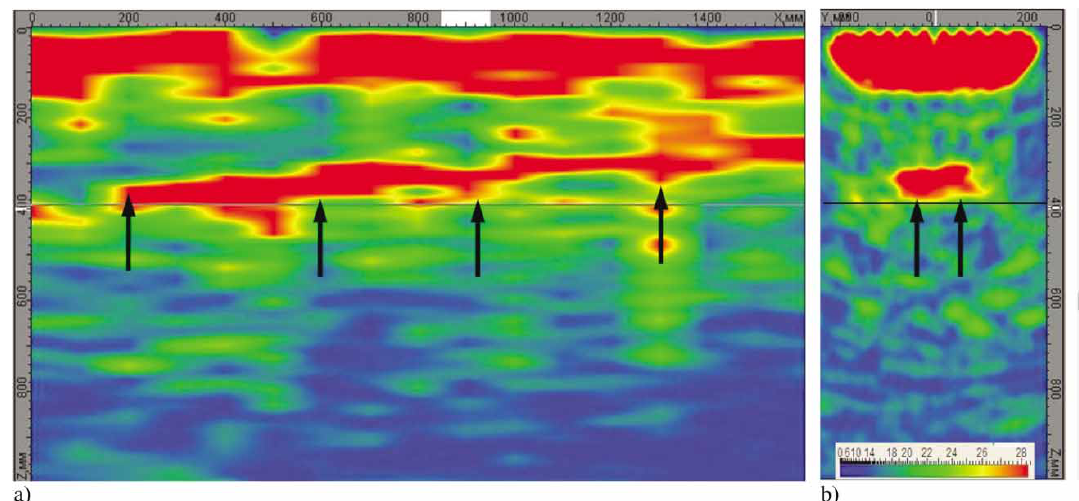
Fig. 9. Exemplary results obtained in measuring place no. 1: (a) image D; (b) image